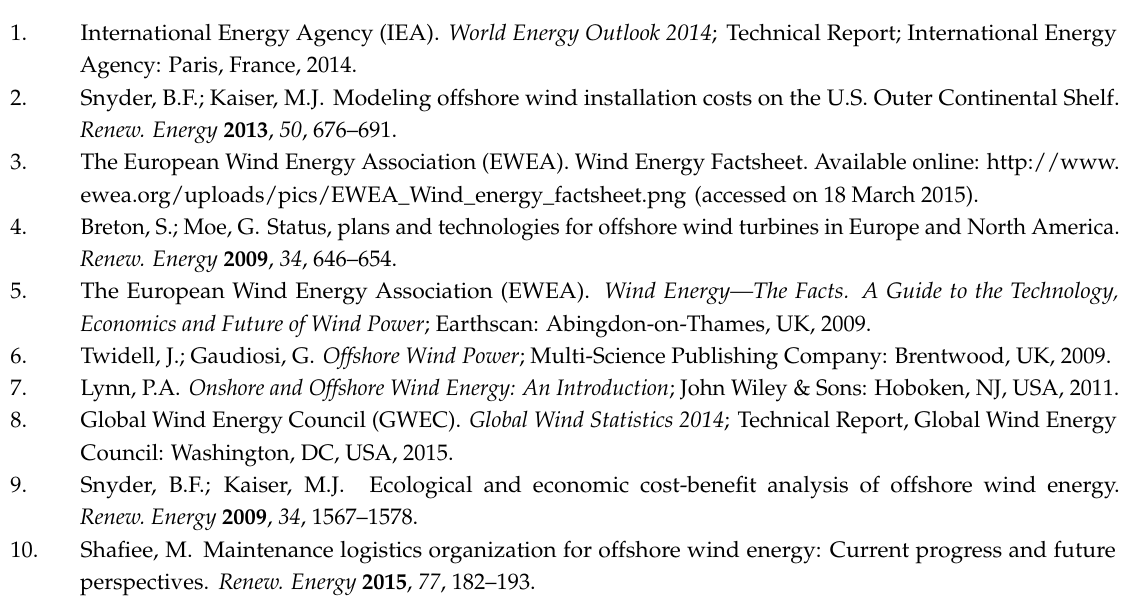
Table S1: Input data of the numerical example of the mathematical model, Table S2: Generated tasks and corresponding task input data of the numerical example of the mathematical model, Table S3: Input data on vessels of the numerical example of the mathematical model, Table S4: Vessel fleet input data used to generate scenarios, Table S5: Maintenance task input data used to generate scenarios, Table S6: General input data used to generate scenarios, Table S7: Wind farm specific input data used to generate scenarios, Table S8: Results for RHH-1 on instances with three shifts. RHH-2 found feasible solutions to all but 3 of the same instances, Table S9: Comparison of the solutions of RHH-2 with symmetry breaking constraints (SBC) and without SBC. The table includes the number of problems where at least one solution is found, the number of problems where RHH-2 with SBC found better solutions than without SBC (with SBC > without SBC), equal solutions (with SBC = without SBC), and worse solution (with SBC < without SBC), Figure S1: Explanation of the illustration figures of the numerical example of the mathematical model, Figure S2: Illustration of shift 1 of the numerical example of the mathematical model, Figure S3: Illustration of shift 2 of the numerical example of the mathematical model, Figure S4: 95% confidence interval for the gap of the solutions when solving the exact model for a planning period of one shift and different numbers of turbines, Figure S5: 95% confidence interval for the difference in objective function value and solution time for the exact model and RHH-1 for problems of 120, 140 and 160 turbines, with a planning period of three shifts. Positive differences mean that the values of the exact model are greater than for RHH-1, Figure S6: 95% confidence interval for the difference in objective function value and solution time for the exact model and RHH-2 for problems of 120, 140 and 160 turbines, with a planning period of three shifts. Positive differences mean that the values of the exact model are greater than for RHH-2, Figure S7: 95% confidence interval for the difference in objective function value and solution time for RHH-2 and RHH-1 for problems of 120, 140 and 160 turbines, with a planning period of three shifts. Positive differences mean that the values of RHH-2 are greater than for RHH-1, Figure S8: 95% confidence interval for the difference in objective function value and solution time for RHH-2 without and with symmetry breaking constraints. Positive differences mean that the values of RHH-2 without the symmetry breaking constraints are greater than with the symmetry breaking